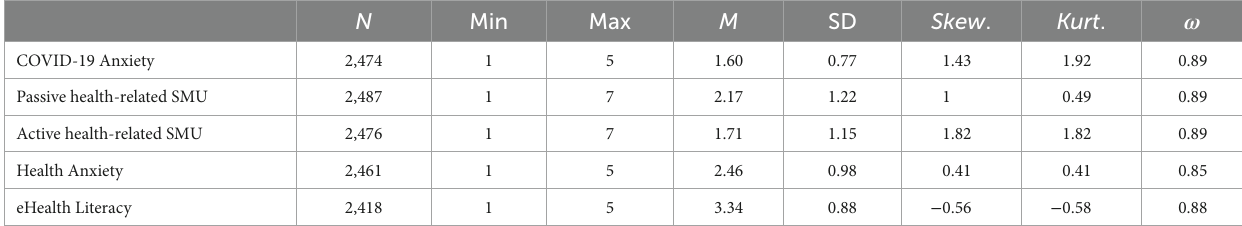
TABLE 2 Descriptive statistics for continuous